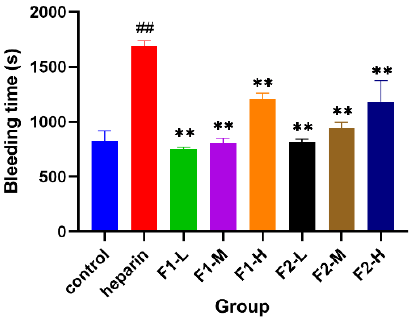
Figure 6. Bleeding effect of F1 and F2. ## p < 0.01 vs. control group; ** p < 0.01 vs. heparin group ( n = 6).